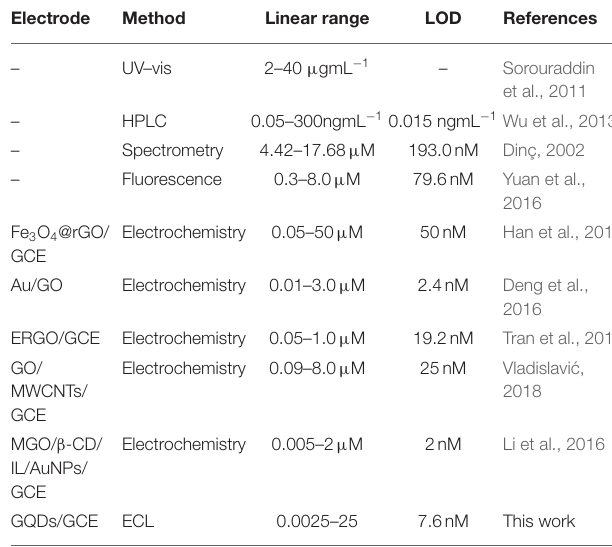
TABLE 1 | Comparison of the system described herein with other reported methods used to detect sunset yellow.